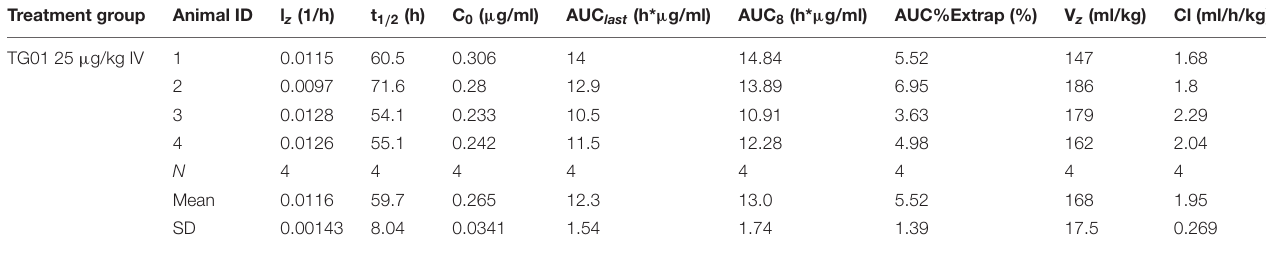
TABLE 2 | Individual and mean pharmacokinetics parameters for PEGpoIFN α in swine plasma following intravenous administration. Treatment group Animal